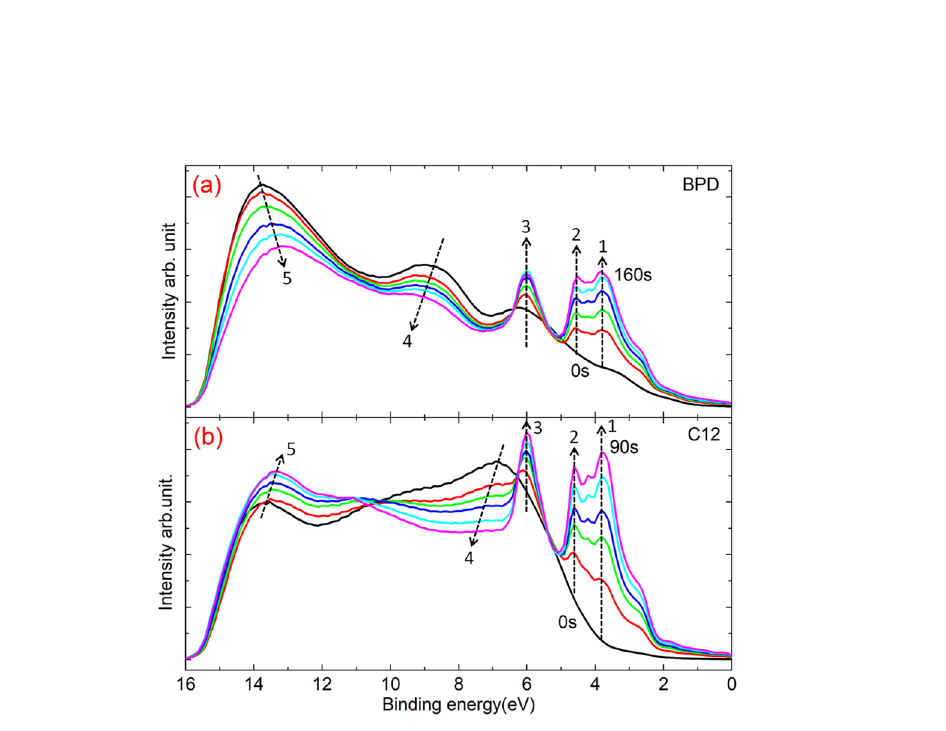
Figure 4. UPS spectra of as-assembled BPD ( a ) and C12 ( b ) SAMs for different etching times ranging from 0 to 90 s for C12 and 0 to 160 s for BPD SAMs. The etching times are 0 s, 10 s, 20 s, 30 s, 50 s, 90 s for C12 and 0 s, 20 s, 40 s, 70 s, 100 s, 160 s for BPD. The complete spectra are given in Fig. S5. Vertical dashed lines indicate the change in the intensity and the energy shift (if any) with etching